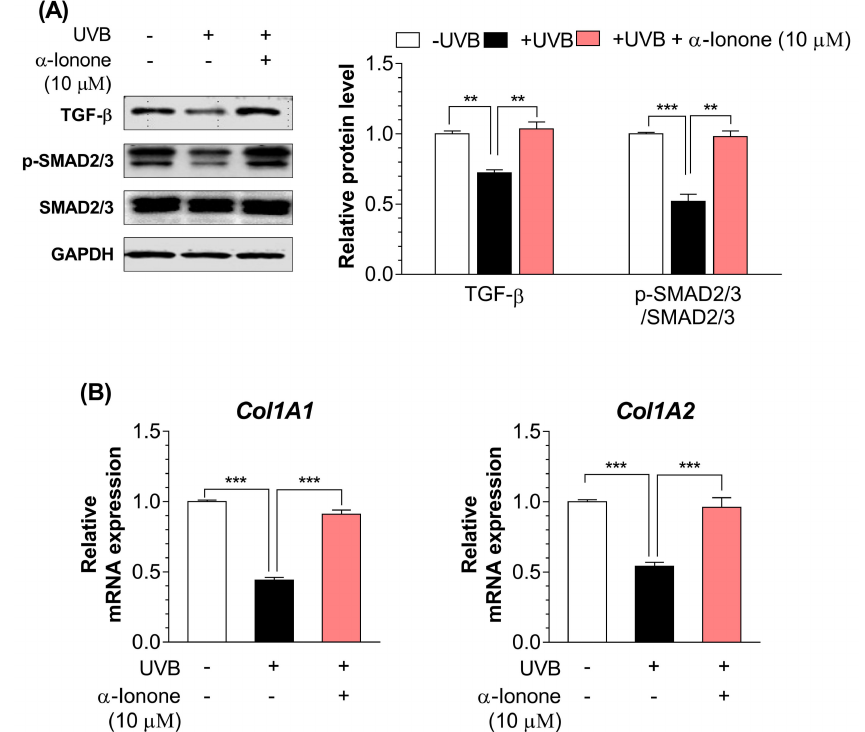
Figure 3. α -Ionone increases the expression of molecules related to collagen synthesis in human Hs68 dermal fibroblasts. ( A ) Protein expression of TGF- β , phospho-SMAD2 / 3, total SMAD2 / 3. ( B ) mRNA expression of Col1A1 and Col1A2 . Values are presented as means ± SEM (n = 3). Significant di ff erences between groups are indicated by asterisks: ** P < 0.01; *** P <